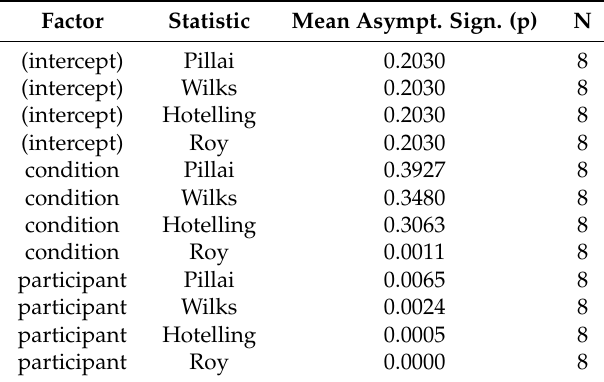
Table 5. Unsupervised learning: Results of